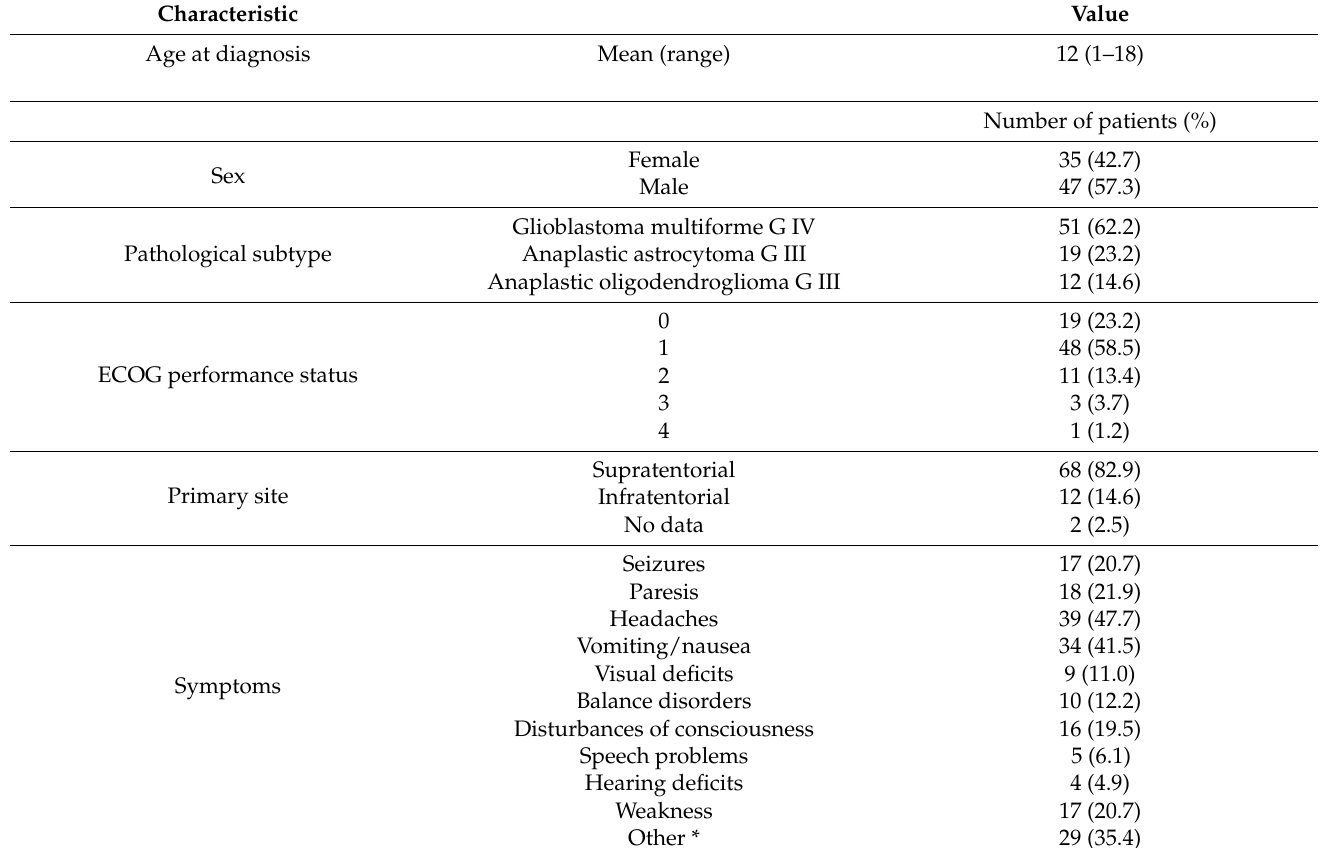
Table 1. The patients’ and treatment